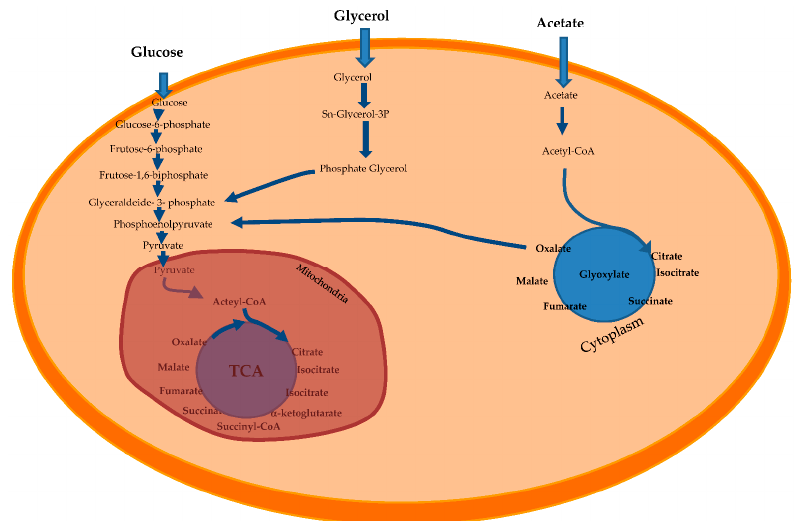
Figure 2. Carbon metabolism by heterotrophic microalgae.